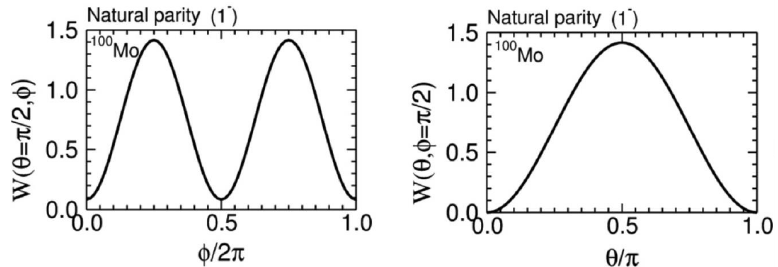
Figure 12. Angular distributions of photo-neutrons via the isobaric analog states from polarized photons on 100 Mo